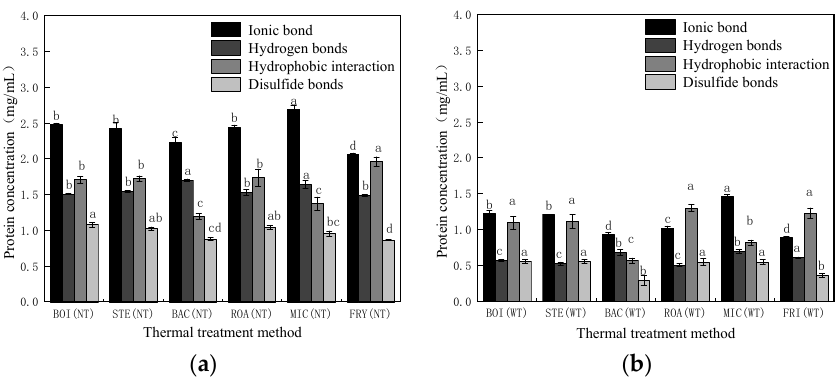
Figure 5. Effect of different thermal treatment methods and the addition of TGase on the chemical action of D. maruadsi surimi products. ( a ): NT; ( b ): WT. BOI: boiled D. maruadsi surimi products; STE: steamed D. maruadsi surimi products; BAC: back-pressure sterilized D. maruadsi surimi products; ROA: roasted D. maruadsi surimi products; MIC: microwaved D. maruadsi surimi products; FRI: fried D. maruadsi surimi products; NT: group of without TGase; WT: group of with TGase. Completely different letters in the same indicator indicate significant differences between the same columns ( p <